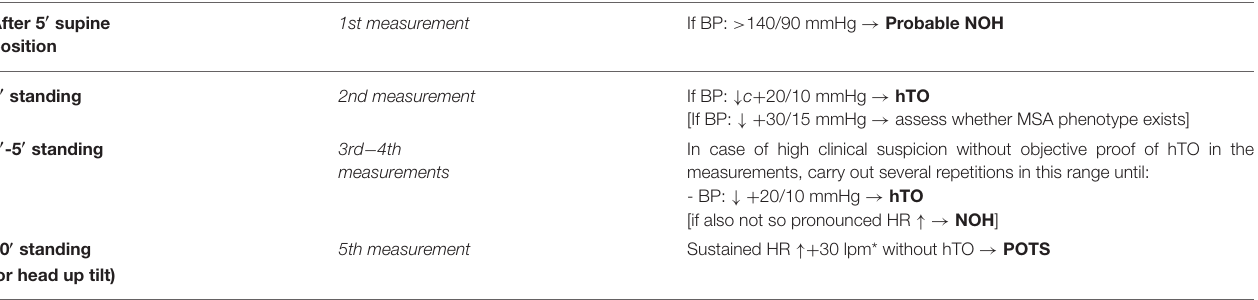
TABLE 1 | Interpretation of blood pressure and heart rate measurements in the event of clinical suspicion of orthostatic hypotension (20) and after differential diagnosis with vertigo, postural instability, ataxia, weakness of leg muscles, and osteoarthritis with weight-bearing musculoskeletal pain. After 5 ′